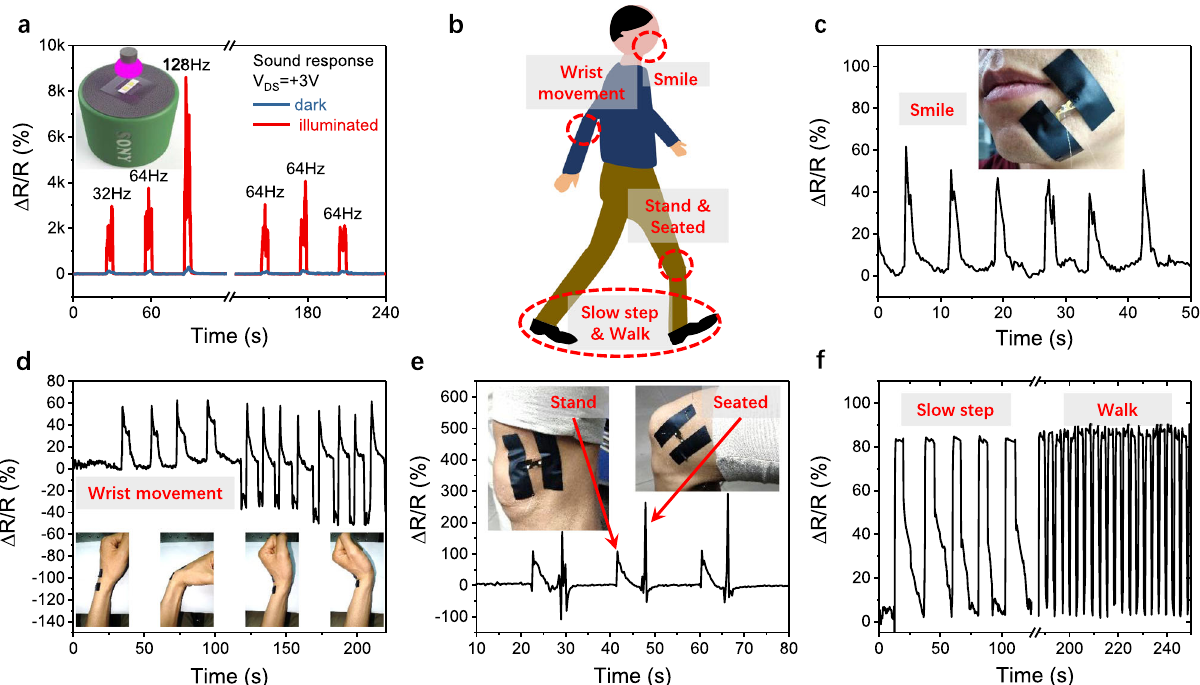
Fig. 4 Demonstration of real world application of VdWLM strain sensor. a The performance of a SnS 2 based strain sensor working under illumination when detecting vibrations induced by sound in comparison to signal when working in darkness. b Schematic of strain points produced by motion of a human body used for strain detection by SnS 2 based devices. c The measured response produced by smile motion for sensor mounted on cheek, as shown in insert. d Response to wrist bending following positions shown below. e Sensor response to motion of standing and sitting corresponding to the insert image for sensor fi xed on knee. f Signals from sensor on knee showing comparative response for slow and rapid